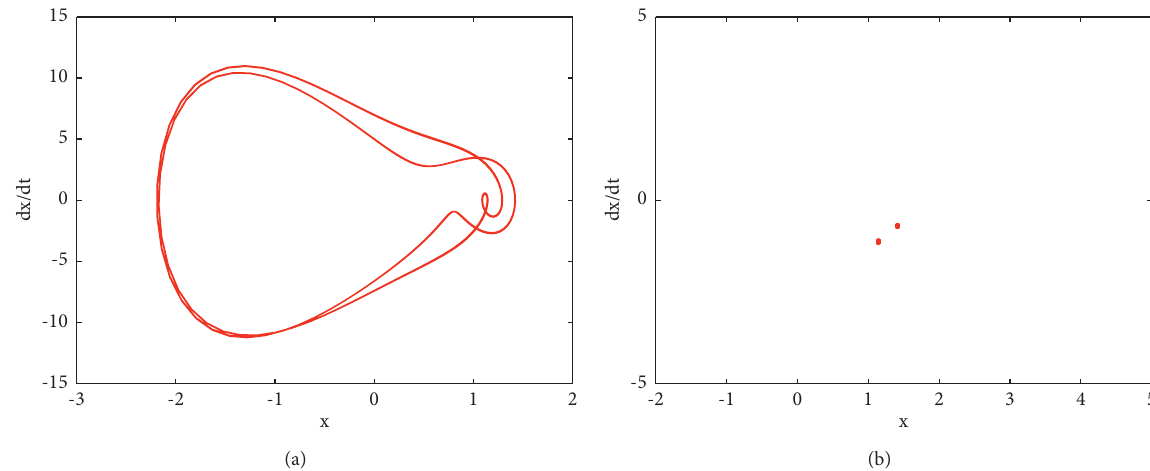
Figure 14: Phase portrait, time history, and Poincar´e cross section diagram of the system at F � 62.80 and τ � 0.8. (a) Phase portrait. (b)